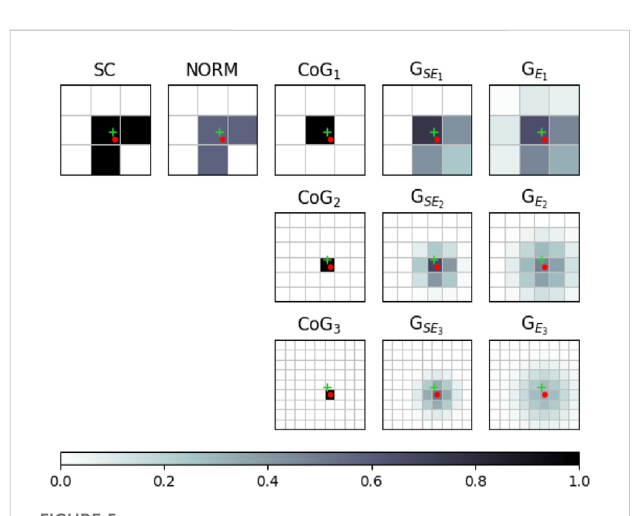
FIGURE 5 Example of single event processing for each of the probed processingmethods.Symbol(+)representstherealimpingingpoint,and (o) represents the computed center of